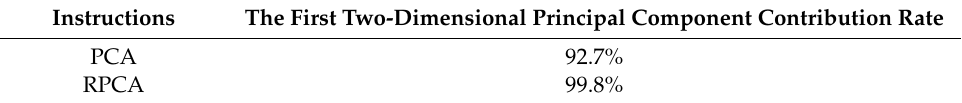
Table 2. Comparison between robust principal component analysis (RPCA) and principal component analysis (PCA).